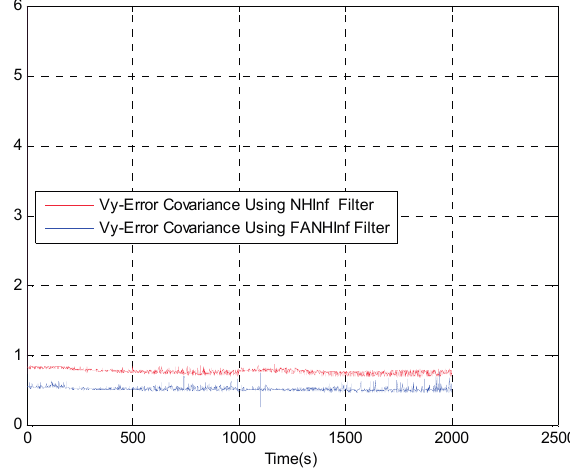
Figure 15. Velocity error covariance in y -axes.